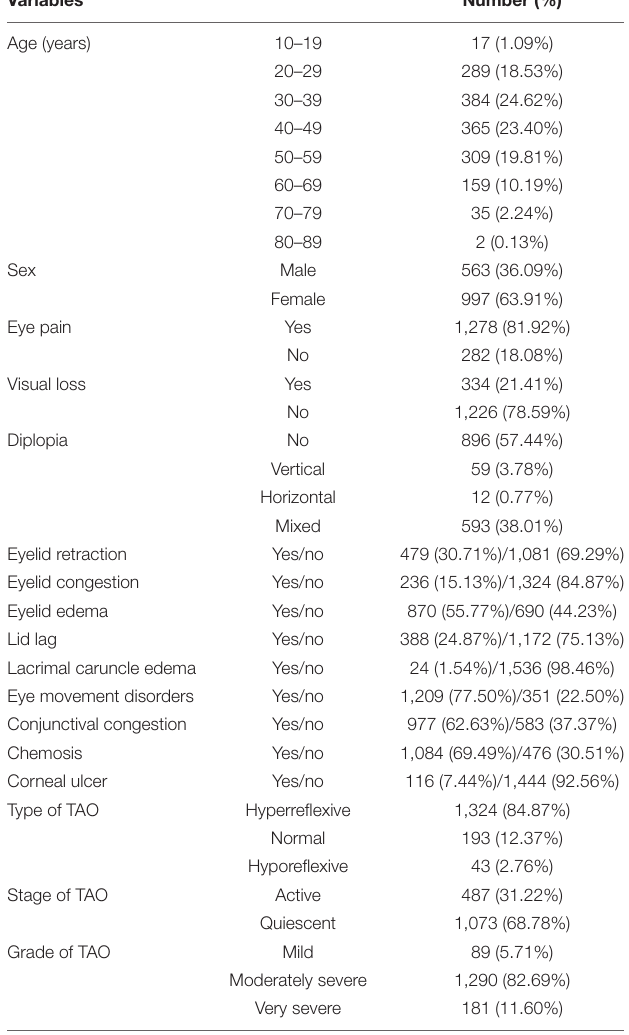
TABLE 2 | Patient characteristics.